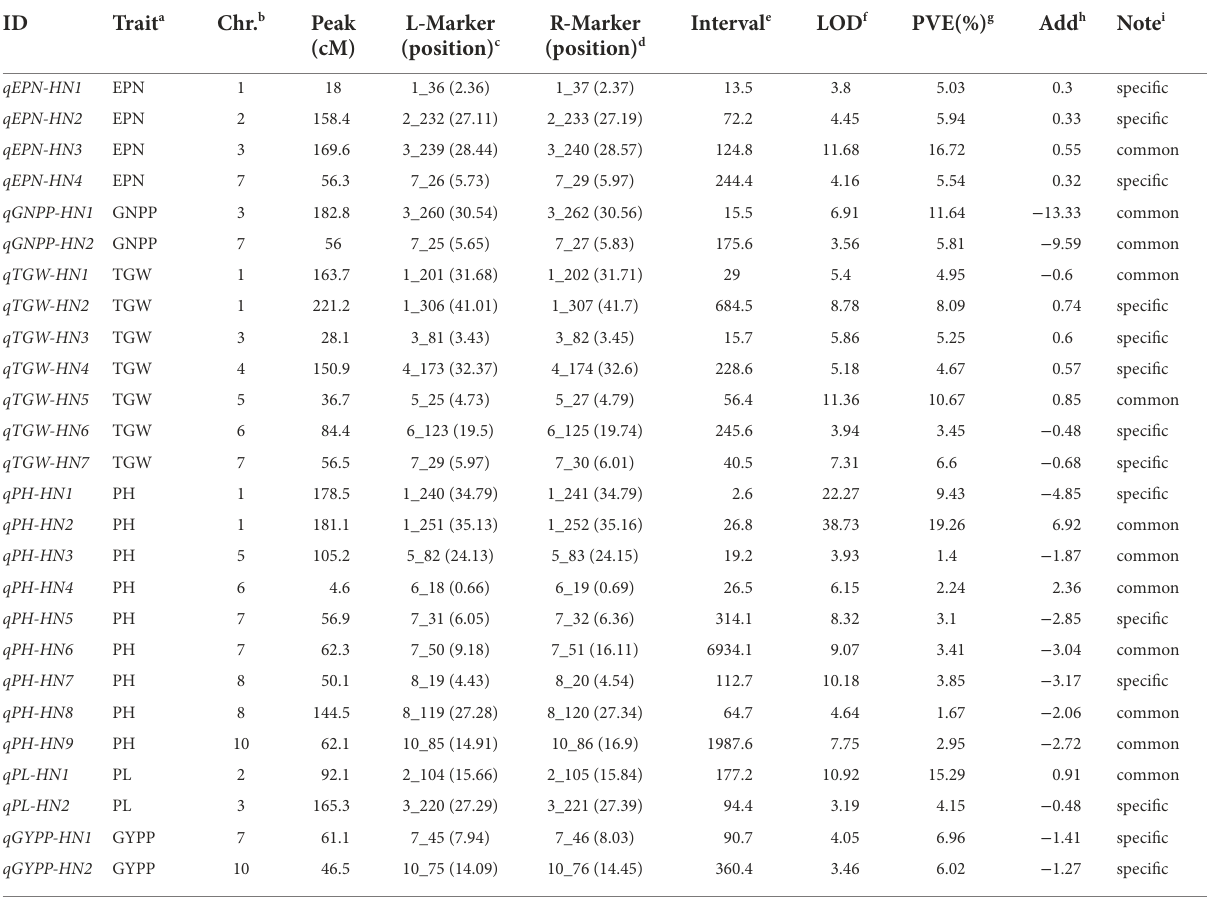
TABLE 3 QTLs associated with seven agronomic traits of the RIL population under HN